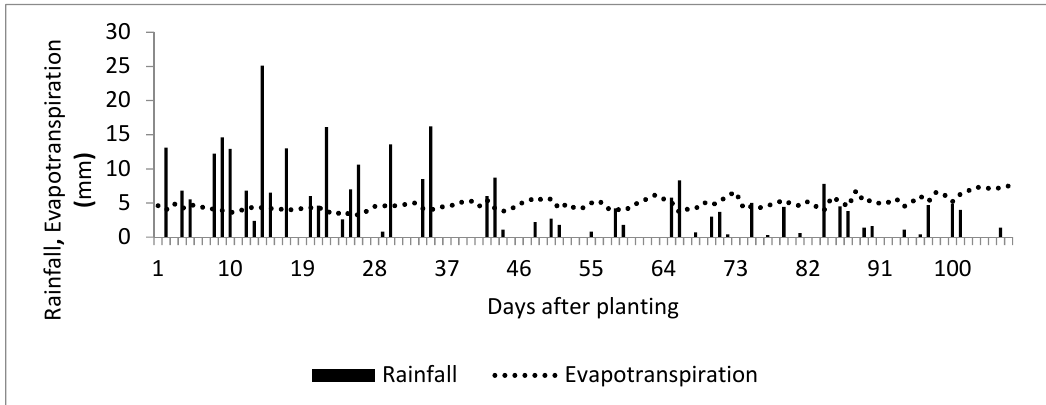
Figure 3. Rainfall and evapotranspiration for the September to December 2015 growing season.